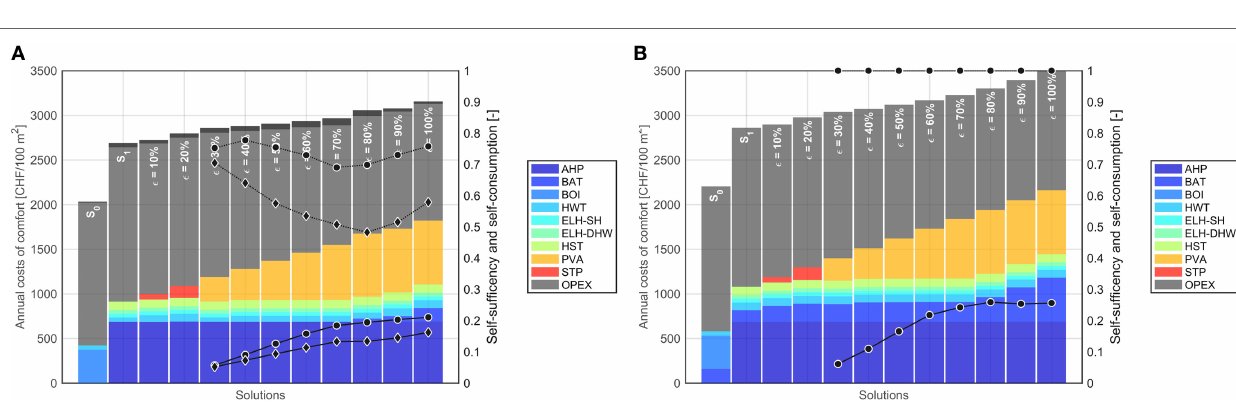
FIGURE 9 | Multi-objective optimization results for a single-family house (Geneva, 1970–1980). Differences in operating costs between both control methods are represented by the dark gray stacked boxes. The self-consumption and self-sufficiency are represented through dotted and solid lines, respectively (MPC circles